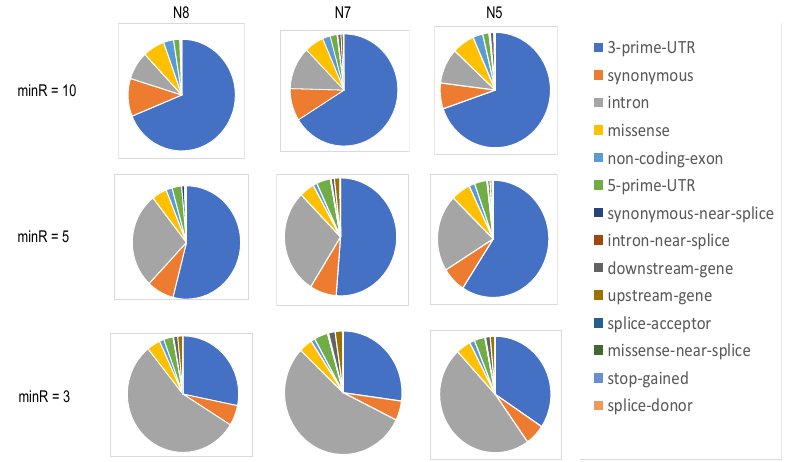
Figure 3. Functional annotation (based on the position in regard to the harboring genes) of SNVs captured by the 10×Genomics platform with different required minimal counts of unique sequencing reads. At minR = 5, over 45% of the SNVs are positioned downstream of the 3 ′ -UTR regions. At minR = 10, close to three-quarters of the captured SNVs were positioned in the 3 ′ -UTRs of the